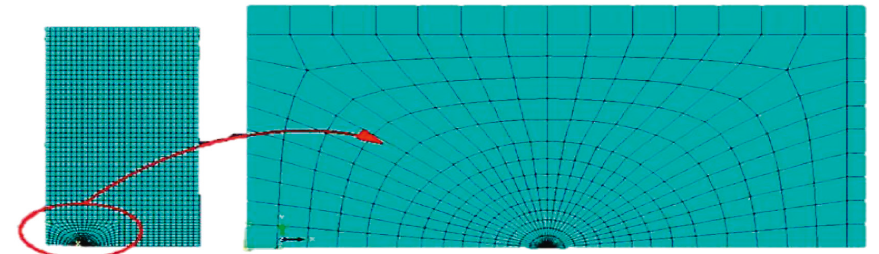
Figure 11: Meshing of the first sample model.